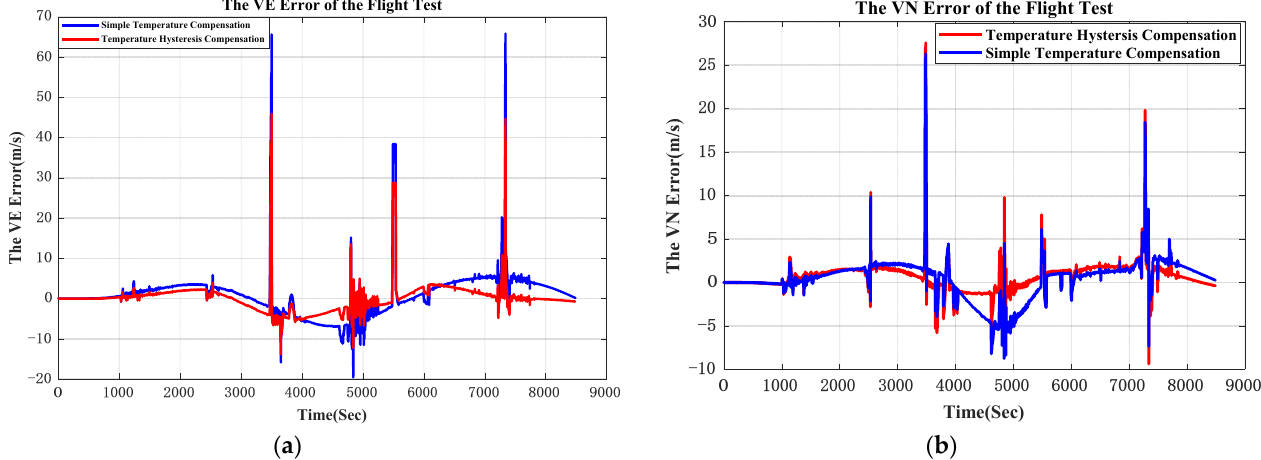
Figure 12. ( a ) is east velocity error; ( b ) is north velocity error. Because the experiment GNSS/INS was assembled inside the cabin and the GPS antenna cannot be installed outside of the cabin, GPS signal was lost when roll angle of the plane was bigger than 30 ° . GPS signal blocked by structure of cabin at big roll angle may be responsible for GPS loss. The vertexes in the graph are caused by the GPS signal loss.